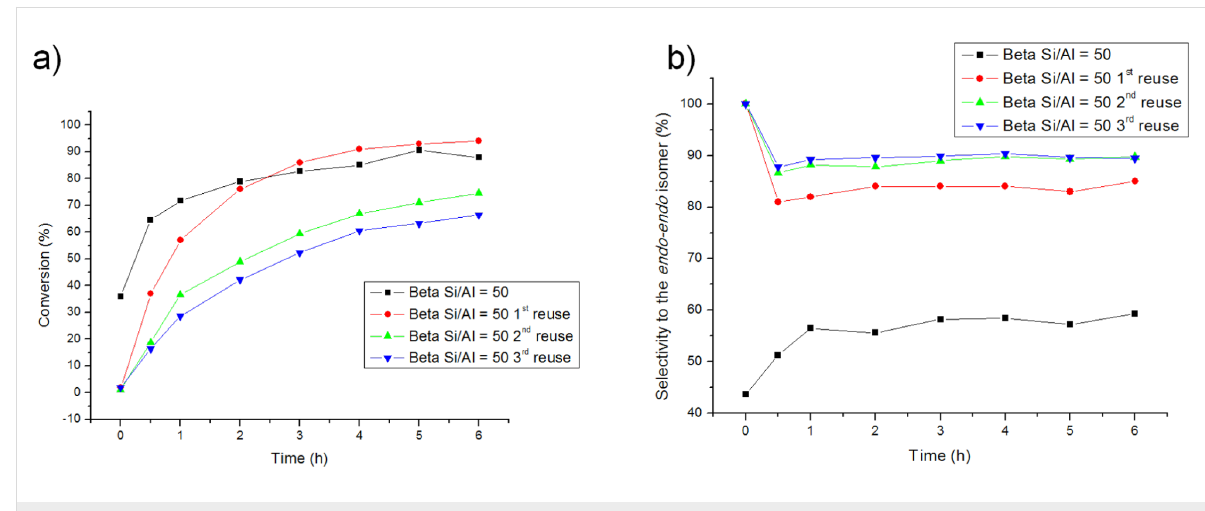
Figure 7: Effect of the reutilization of the catalysts in the conversion (a) and selectivity (b) of the